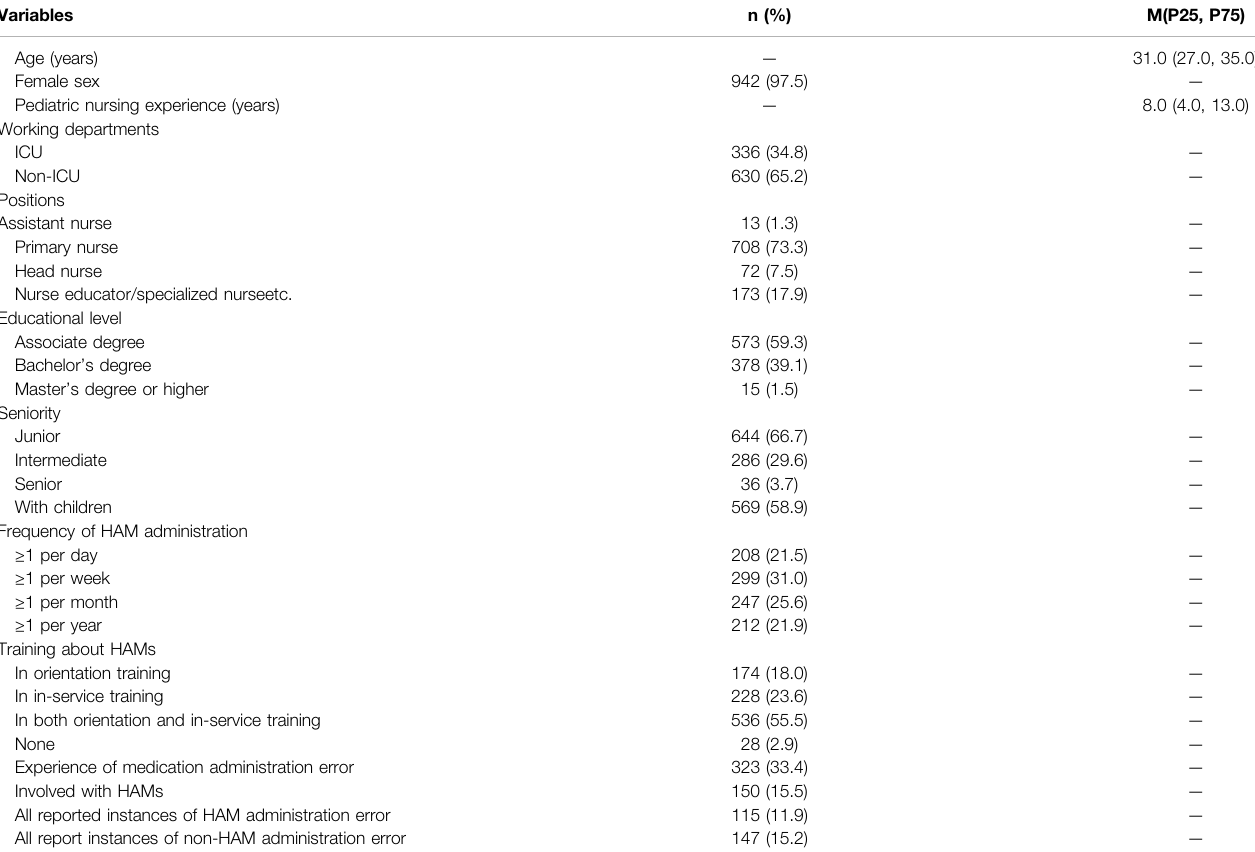
TABLE 1 | Demographic characteristics ( N =